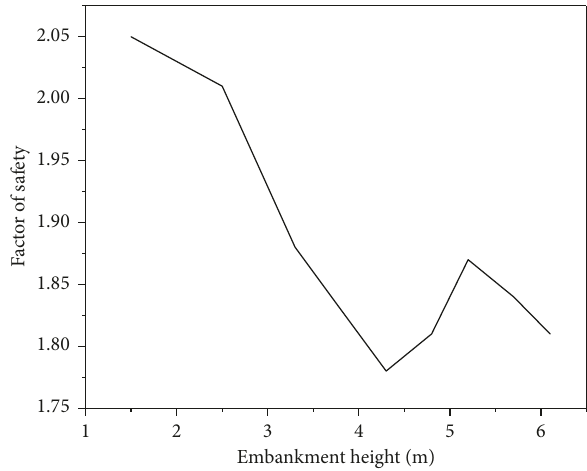
Figure 11: Factor of safety of during the